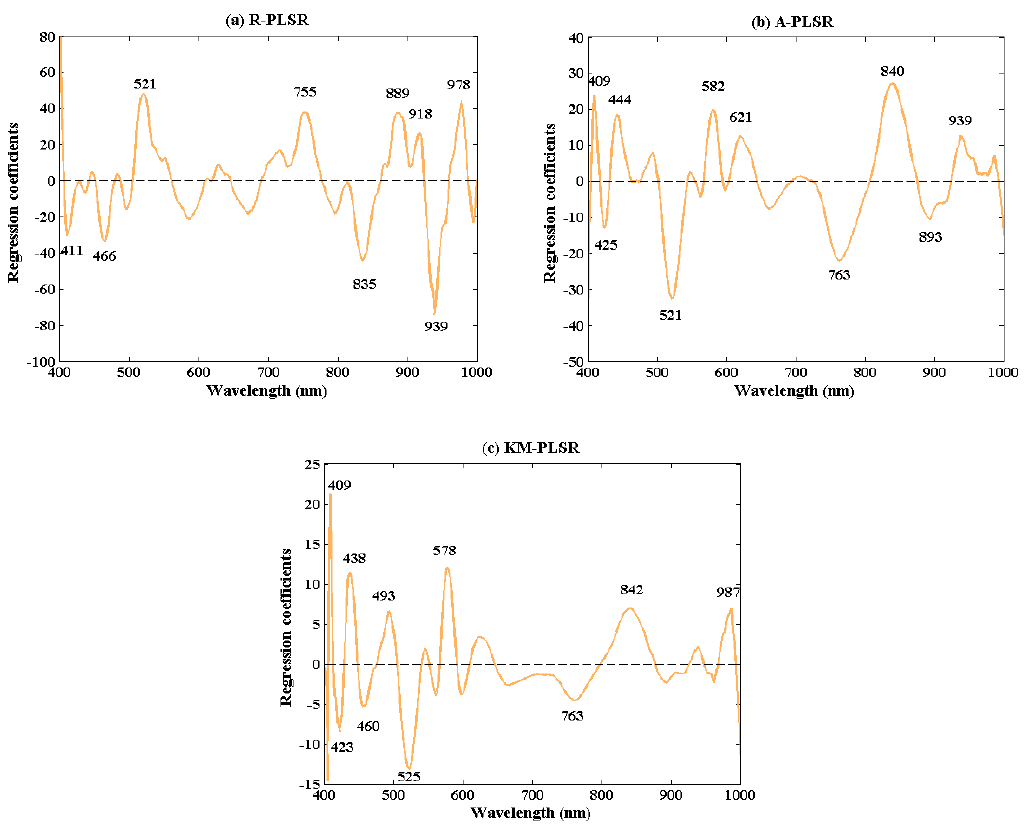
Figure 4. Determination of informative wavelengths by regression coefficients (RC) of ( a ) R-PLSR, ( b ) A-PLSR, and ( c ) KM-PLSR models.